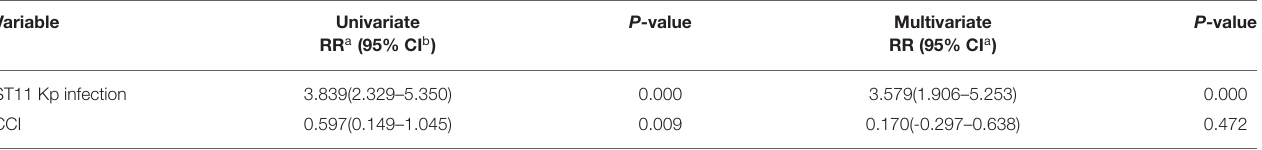
TABLE 4 | Risk factors for an elevated SOFA